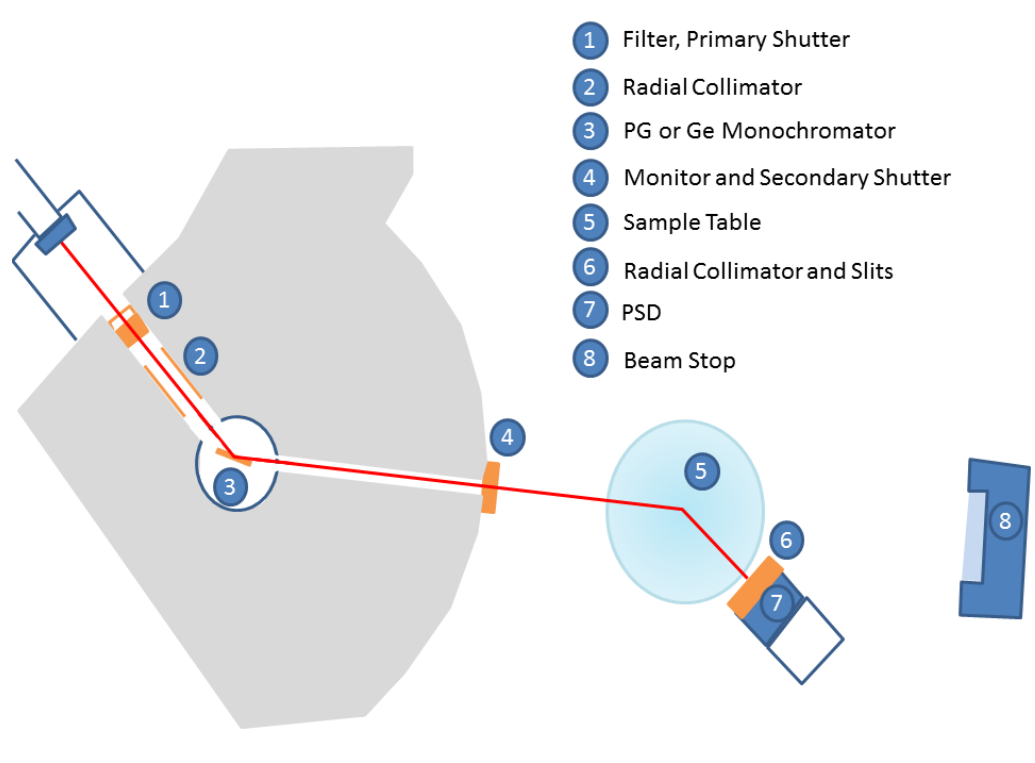
Figure 2: Schematic view of